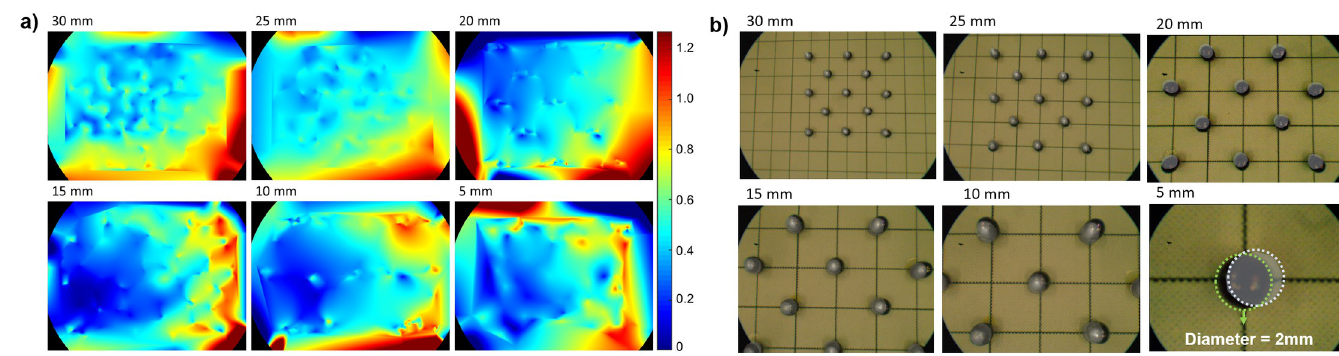
Fig 9. a) Error distribution, expressed in mm, of the image overlay on the endoscopic view at several distances between the endoscope and the grid. Blue represents areas with lower TRE, and red indicates areas with larger TRE. b) Steel spheres segmented from the CBCT and overlaid on the endoscopic view at several distances between the endoscope and the